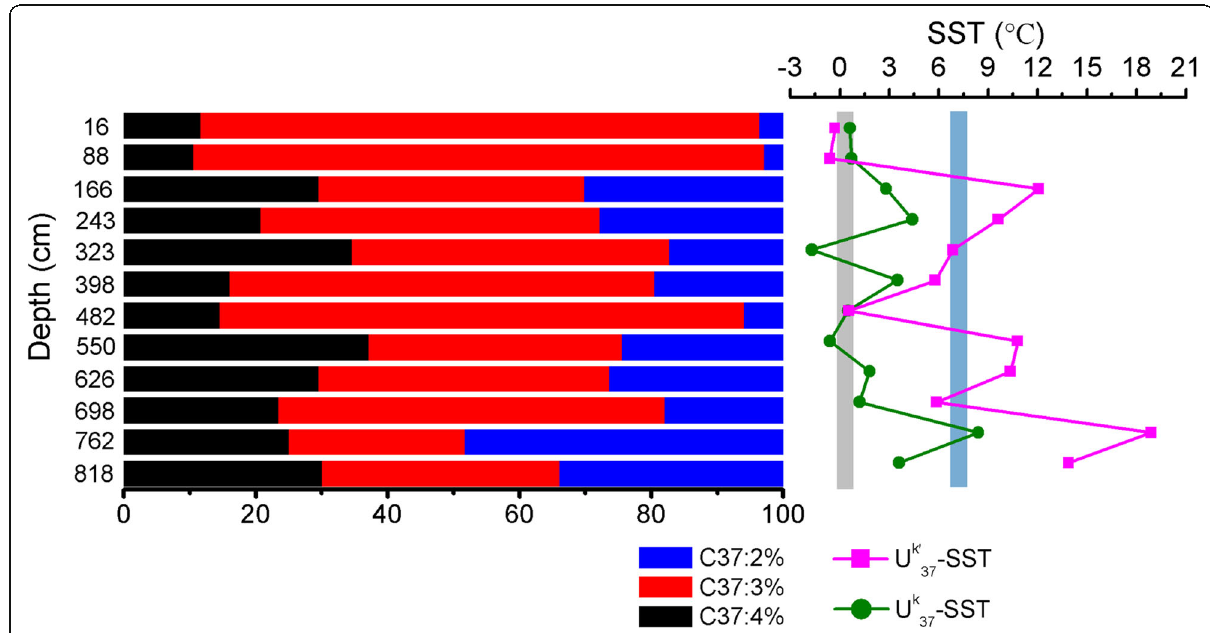
Fig. 6 The relative abundance of C 37:4 , C 37:3 , and C 37:2 alkenones and the calculated sea surface temperature based on U k different depths of the core R23. The light gray and light blue bands represent modern average summer SST based on the World Ocean Atlas (WOA09) data set (Locarnini et al. 2010) and highest SST during the Holocene at the same latitude of the Southern Ocean from previous studies (Kim et al. 2012; Etourneau et al. 2013),